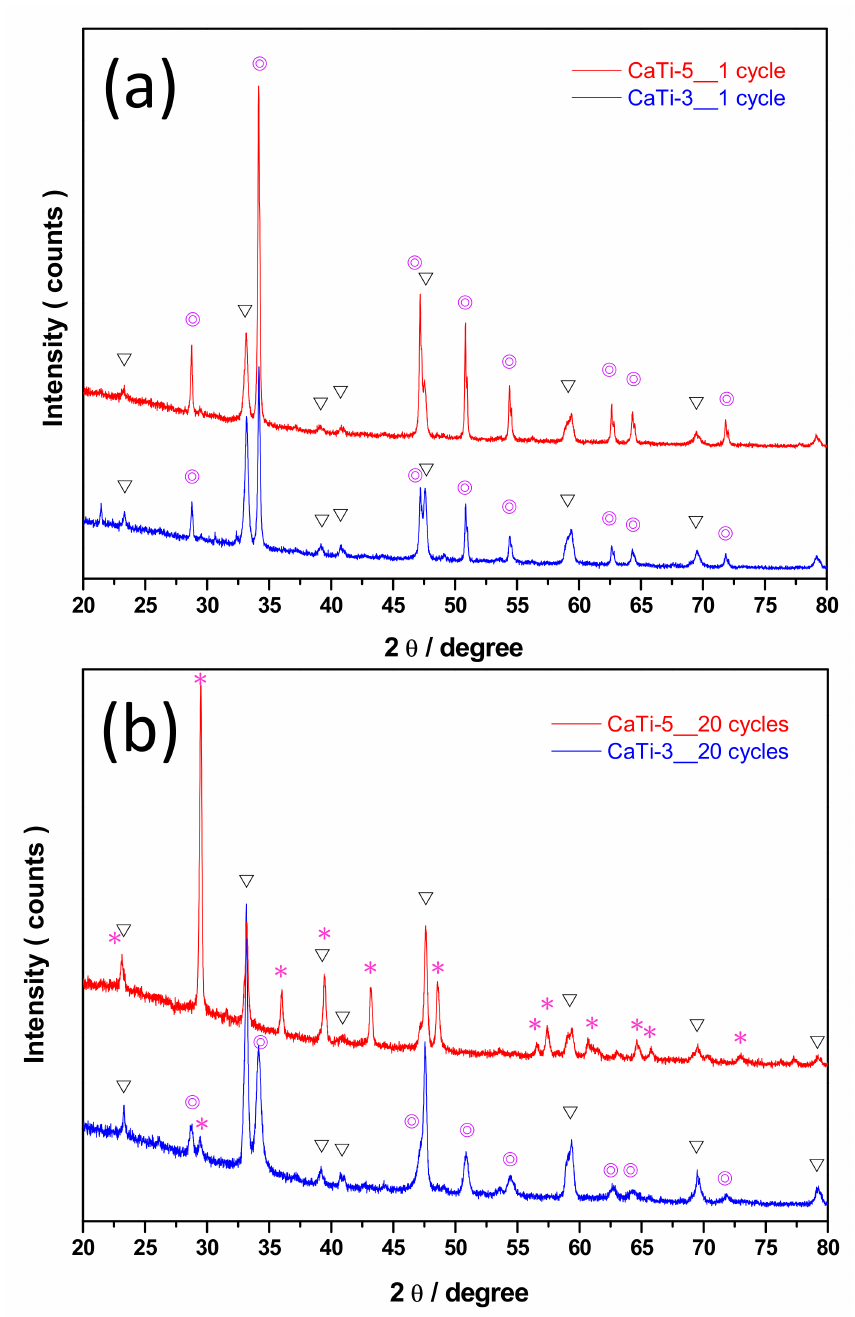
Figure 6. XRD results of ( a ) CaTi-3 and ( b ) CaTi-5 collected from after 1 cycle and 20 cycle experiments, where the invert triangle symbol represents CaTiO 3 , the circle symbol represents Ca(OH) 2 , and the star symbol represents CaCO 3